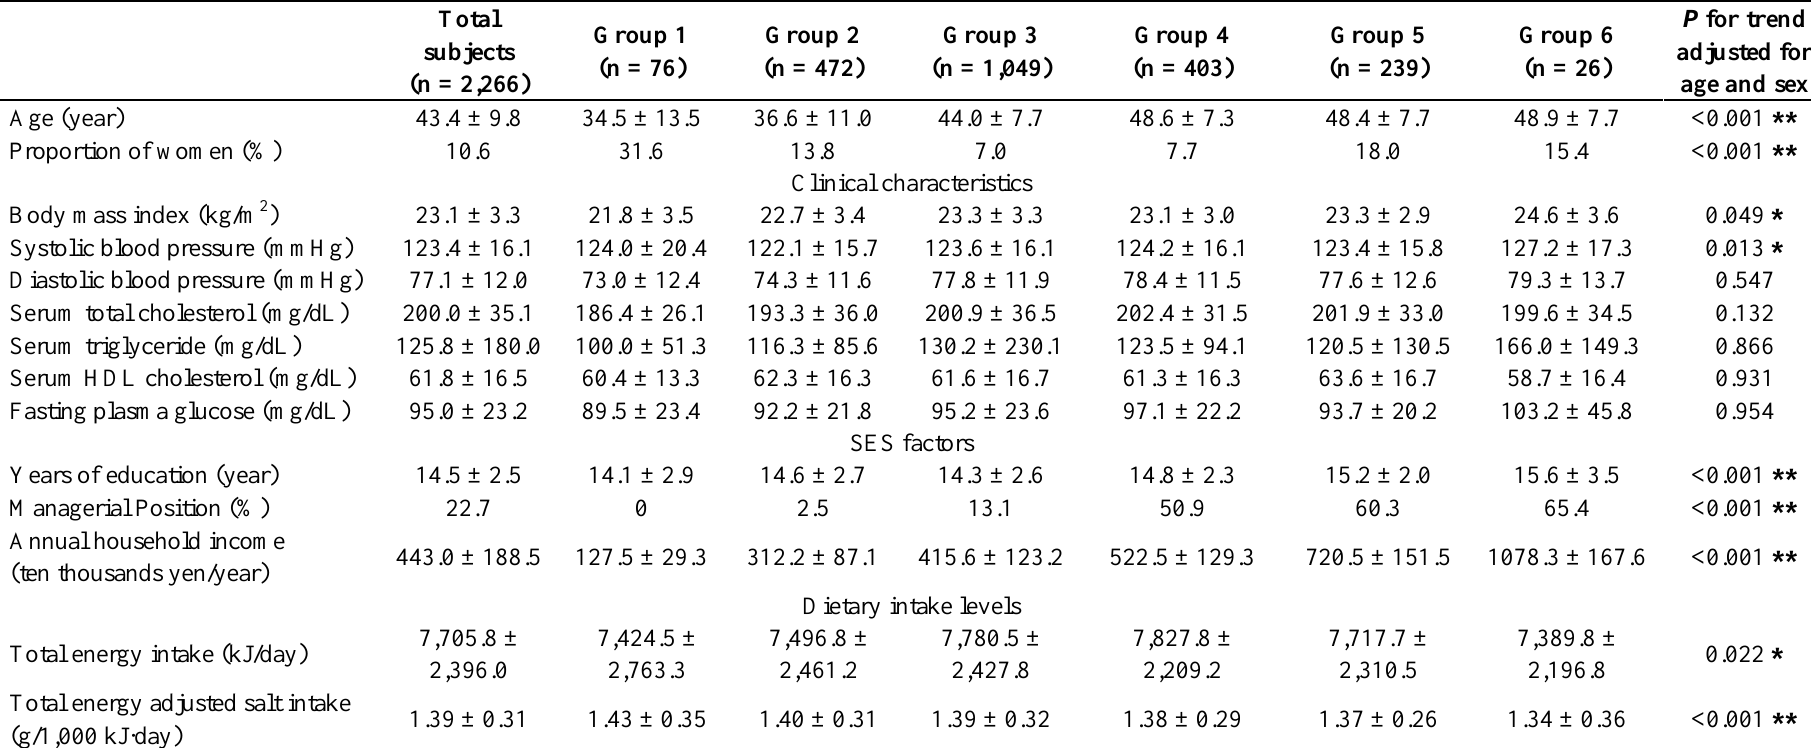
Table 2. Clinical characteristics, dietary nutrients intake data, and socioeconomical status factors of the study subjects according to different household income